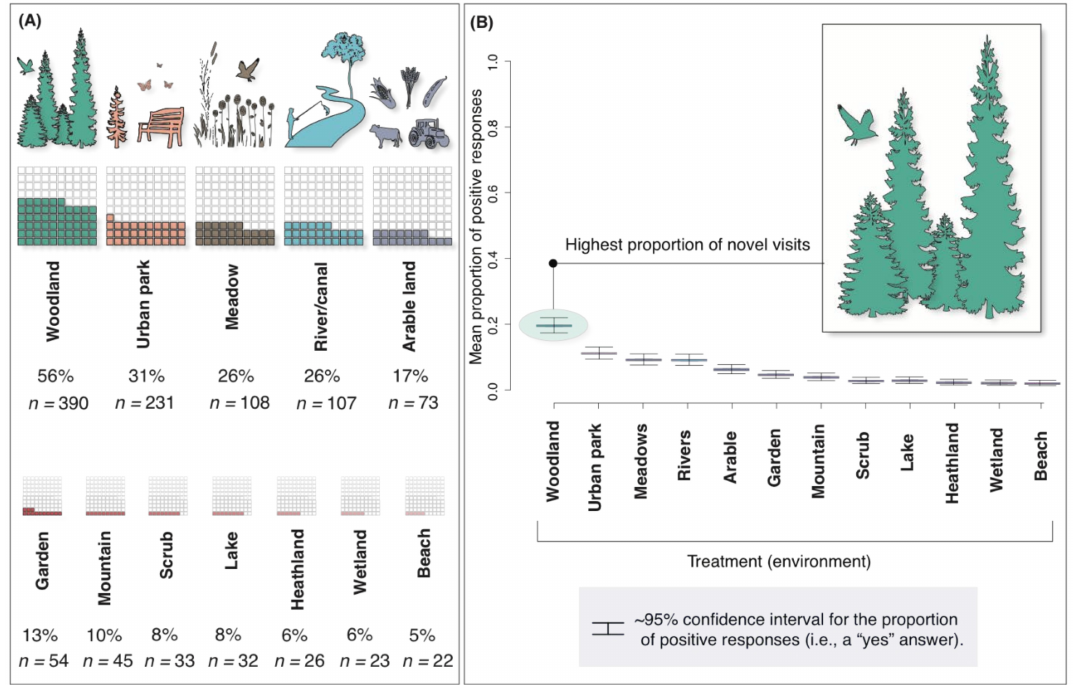
Figure 5. Proportions of participants who visited natural environments they would not usually visit (as a result of the COVID-19 pandemic). The top left ( A ) waffle plots show the most popular natural environments and ( B ) boxplot for the GLM analysis, shows means and approximate 95% confidence intervals for the proportion of positive responses, where “yes” was recoded to